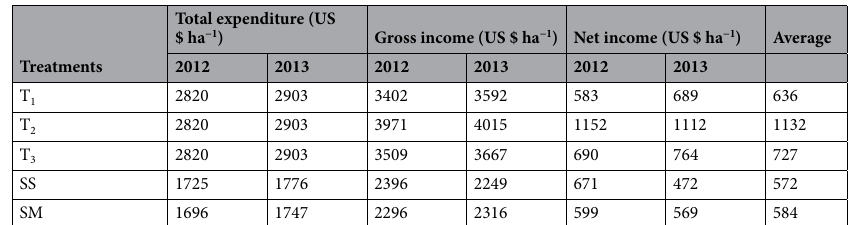
Table 7. Economic analysis for the effects of different strip width treatments on maize and soybean production in 2012 and 2013. Treatment codes represent narrow-strips (T1, 180 cm); medium-strips (T2, 200 cm); and wide-strips (T3, 220 cm) in maize/soybean relay intercropping system. SS is the sole cropping system of soybean, and SM is the sole cropping system of maize. The exchange rate of the per US dollar in 2012 and 2013 was 6.23 and 6.05 Chinese RMB (Yuan),